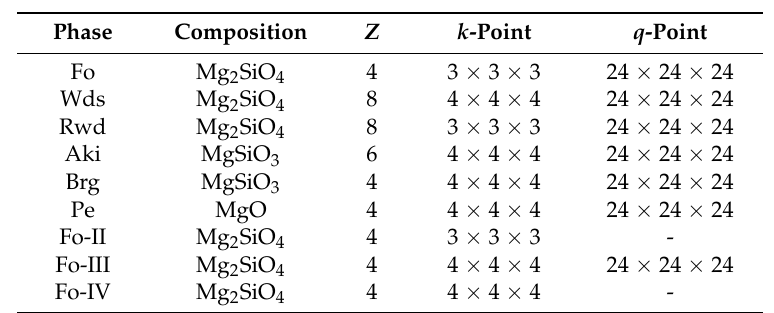
Table 1. Selected setting parameters in static and quasiharmonic approximation calculations for Fo, Wds, Rwd, Aki, Brg, Pe, Fo-II, Fo-III and Fo-IV.